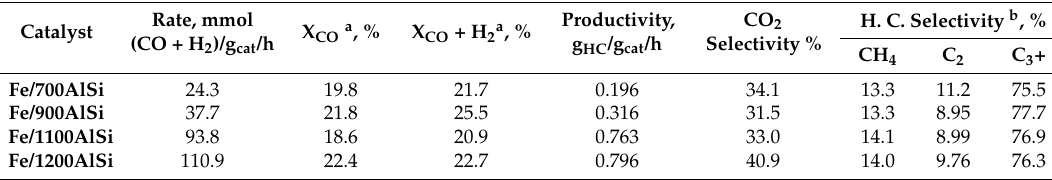
Table 7. Performance of four catalysts with different support temperatures in fixed bed reactor. T = 260 °C, H 2 /CO = 1, P = 20 bar.